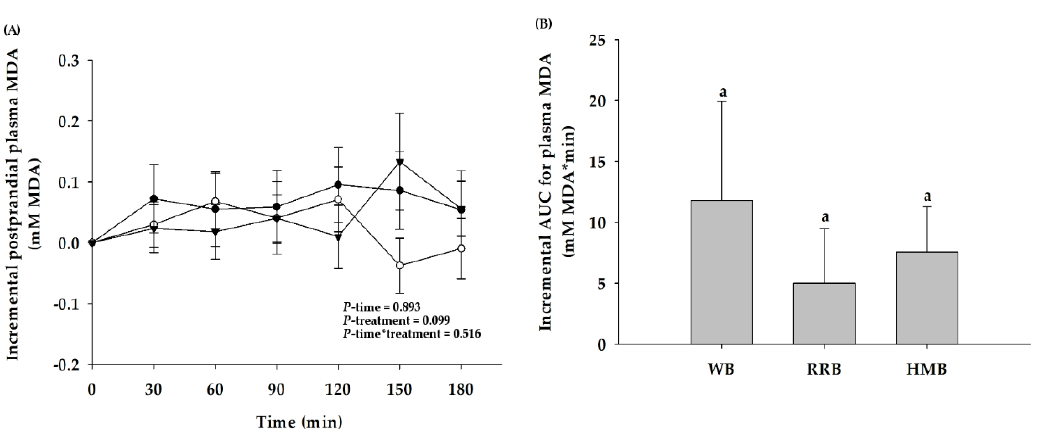
Figure 9. ( A ) Changes in postprandial malondialdehyde (MDA) level and ( B ) the iAUCs for plasma MDA level of healthy participants after the consumption of wheat bread (WB), Riceberry rice bread (RRB), and Hom Mali bread (HMB). All values are means ± SEM, n = 16. WB (●), RRB, ( ○ ), and HMB ( ▼ ). For each time point, means with a different letter are significantly different, p < 0.05.